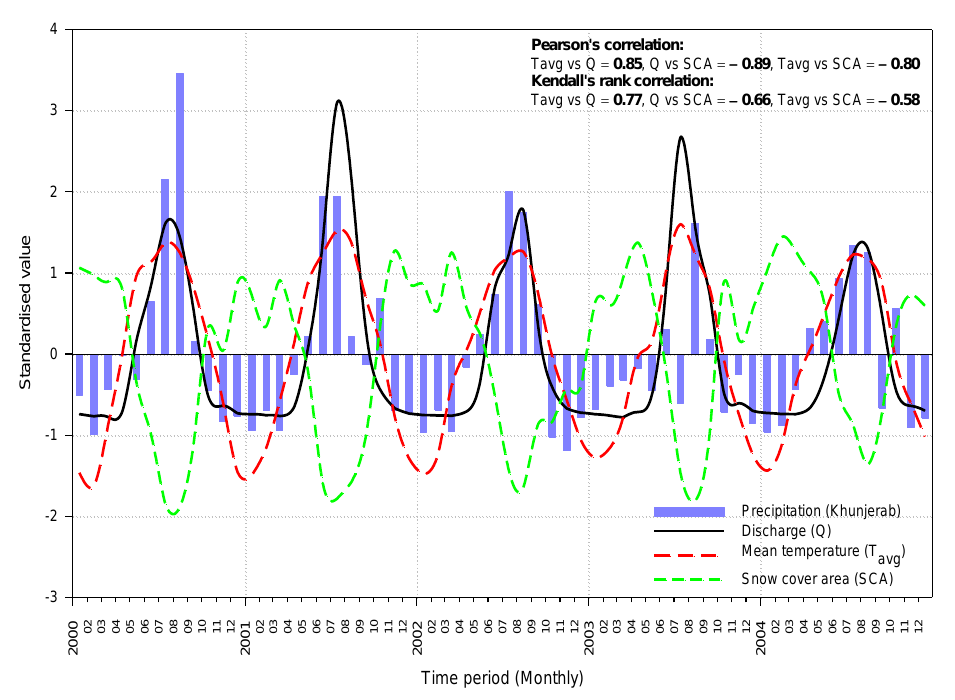
Fig. 7 Correlation between standardised values of precipitation (Khunjerab), snow cover, average temperature and discharge (at Dainyor) in the Hunza River basin (on a monthly basis). All the correlation values are significant with a significance level, p <0.05.